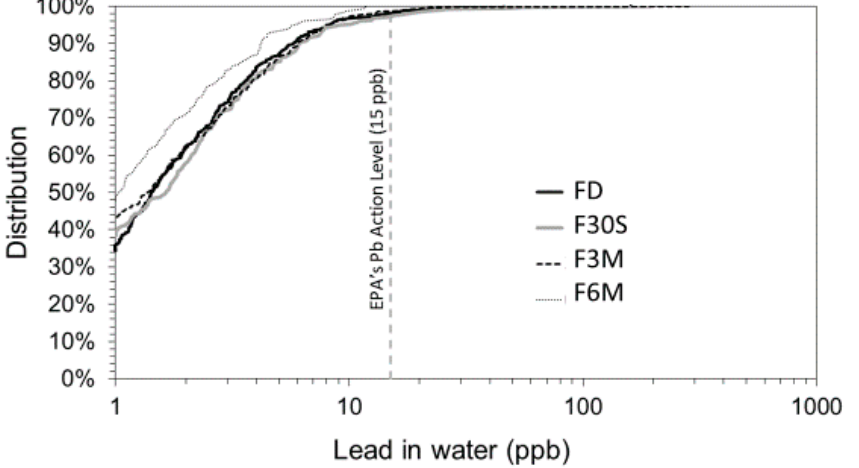
Figure 1. Cumulative distribution of total water lead levels (WLLs) in occupied normal-use homes by sample type ( n = 1497 samples from 376 sites). Key: FD: first draw; F30S: 30–45 s total flush; F3M: 2.5–3 min total flush; F6M: 5.5–6 min total flush.